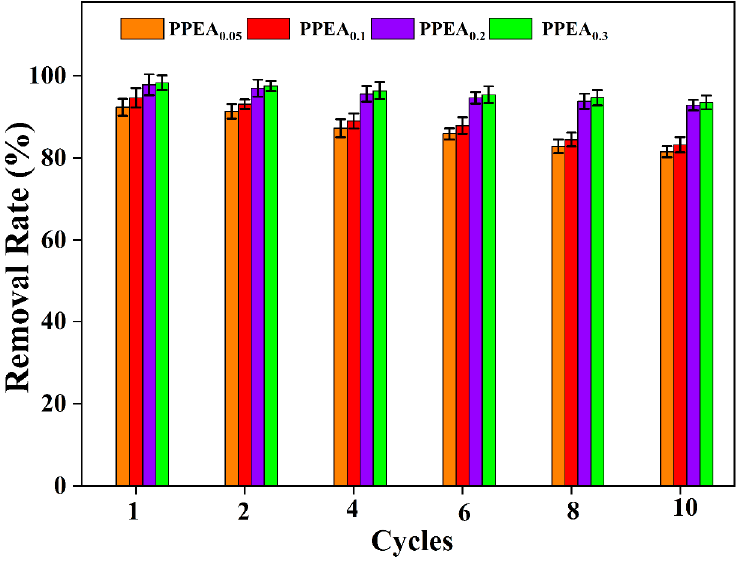
Figure 7. Pb 2+ removal efficiency of the PPEAs during the adsorption–desorption cycles.